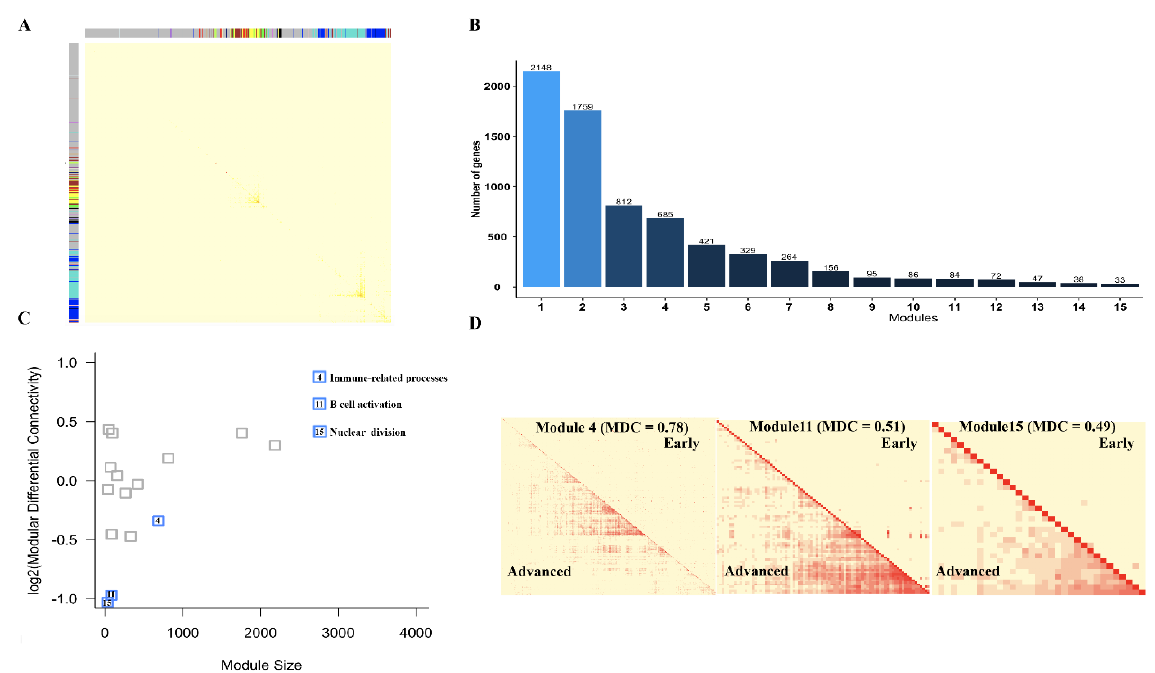
Figure 4. Differential modular connectivity analyses for early and advanced stage individual genes. ( A ) Gene co-expression network module in different stages of atherosclerotic plaque. The rows and columns represent the same set of 16,220 genes with the first 75% variance in the dataset of GSE28829. ( B ) The numbers of modules and genes in weighted gene co-expression network modules based on the dataset of GSE28829. ( C ) Differential connectivity modules are highlighted. The y-axis represents the log2 transformed modular differential connectivity values. The x-axis denotes the number of genes in the corresponding modules. ( D ) Heatmap of gene-gene correlation in the differential connectivity of modules in the early stage (the upper right triangle of each module) compared with that in the advanced stage (the lower left triangle of each module).